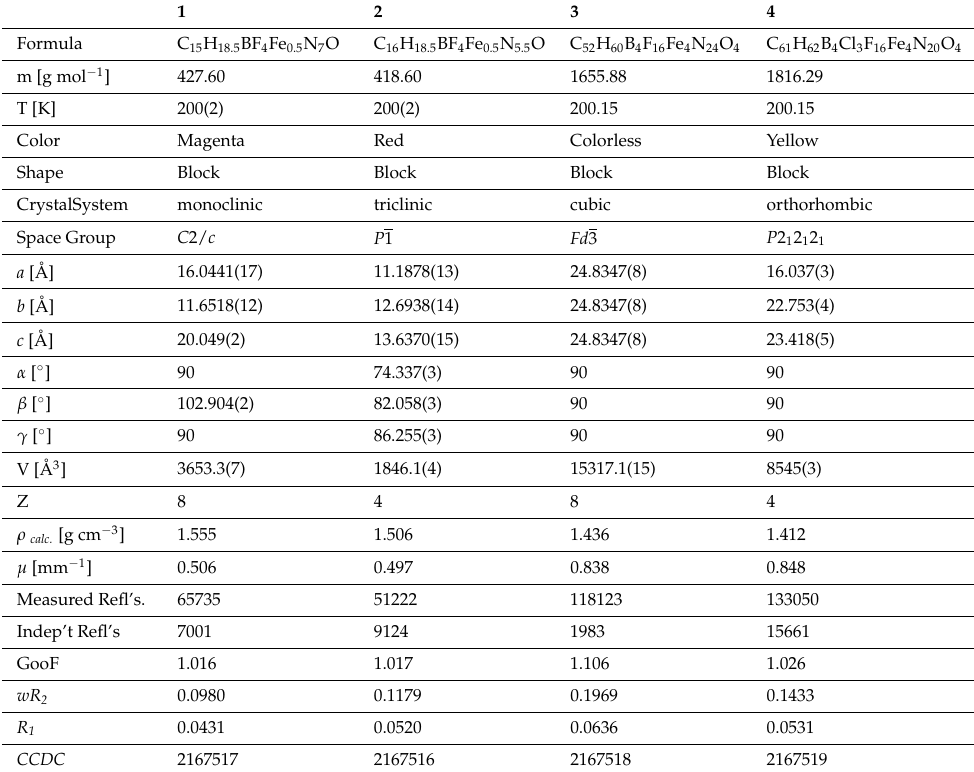
Table 2. Crystallographic parameters for structures 1 – 4